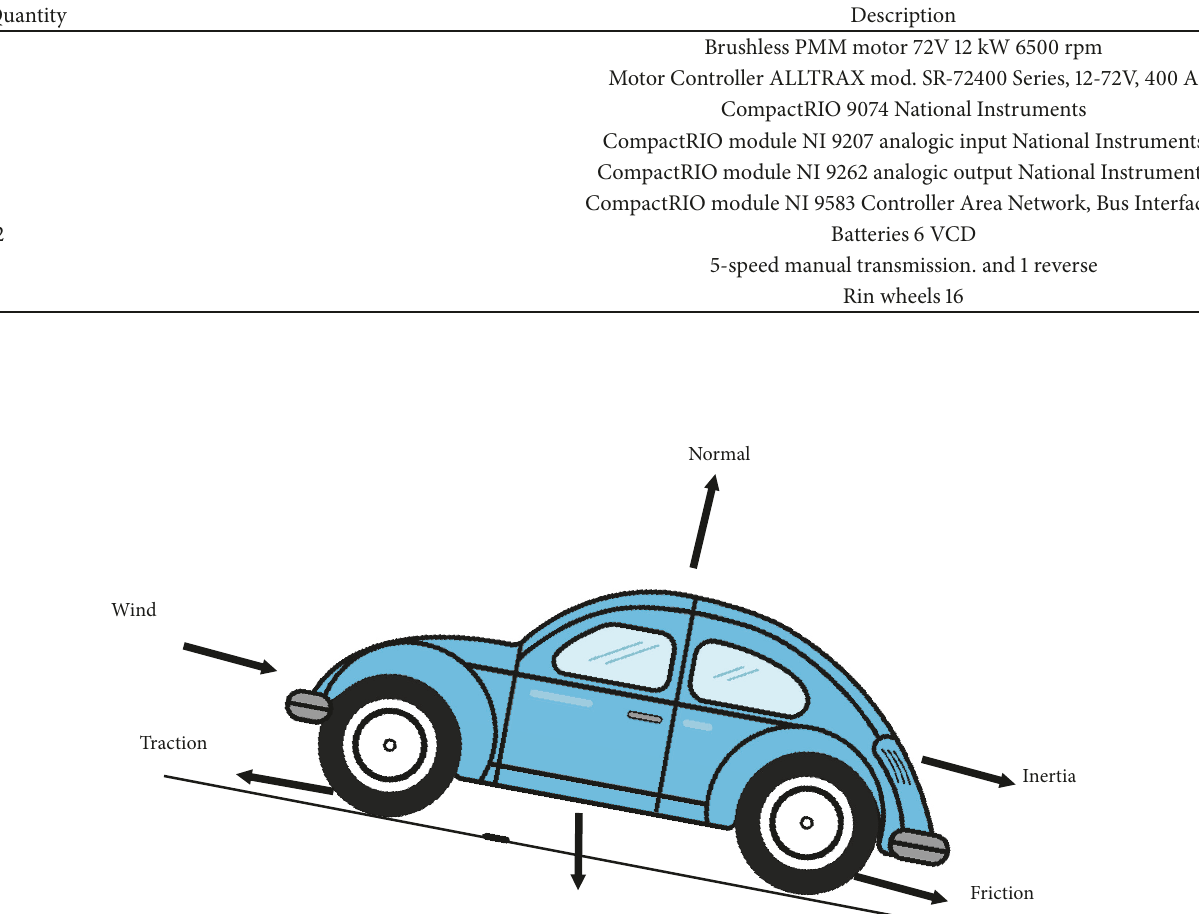
Table 2: Description of the modified EV components.